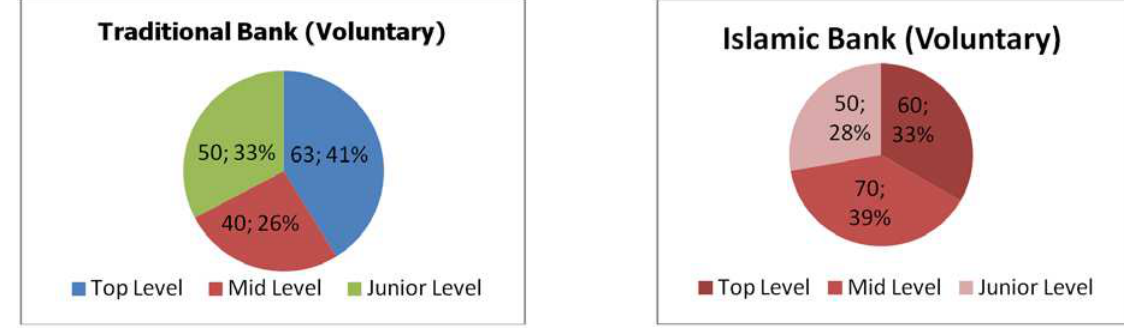
Fig. 3. CSR activities are voluntary or mandatory